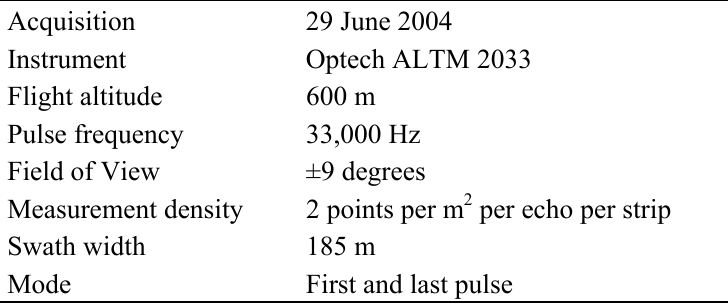
Table 1. ALS data collected from the study sites.